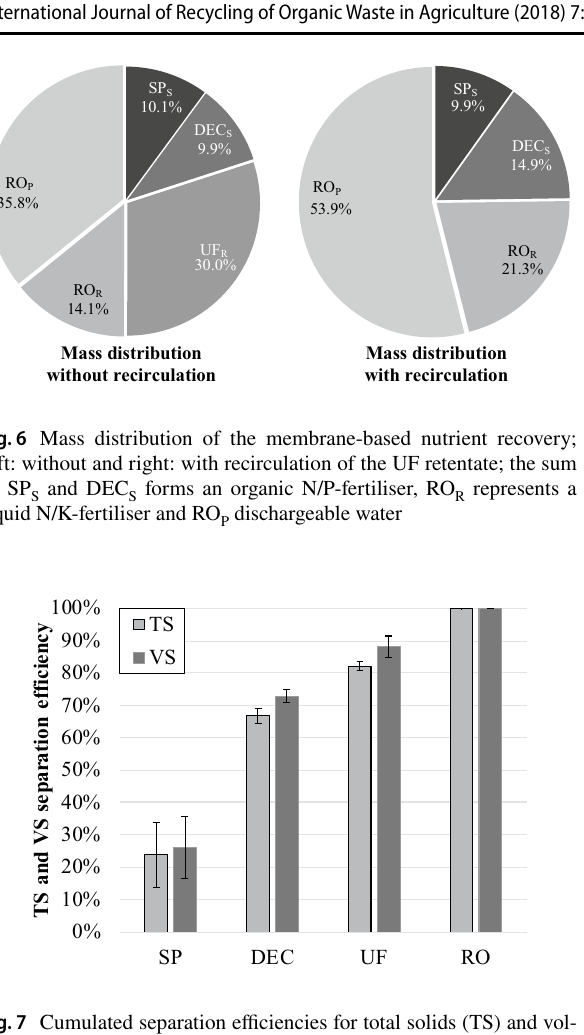
Fig. 7 Cumulated separation efficiencies for total solids (TS) and vol- atile solids